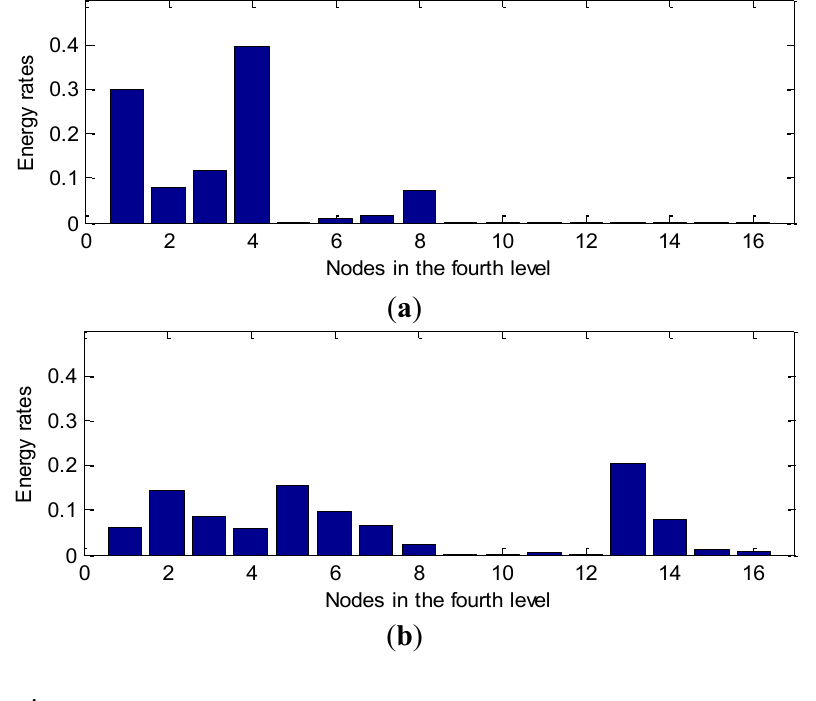
Figure 10. The normalized feature analysis of wavelet packet node energy in Figure 9: ( a ) the normal bearing. ( b ) the BF14